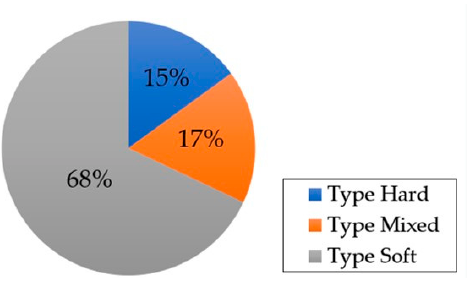
Figure 6. Proportional quantitative results of the different types of inclusions present in steel E. Once the micrographs were obtained and selected according to the type of inclusion, they were measured using the image analysis program AnaliSYS. 3.1 ® . In order to study